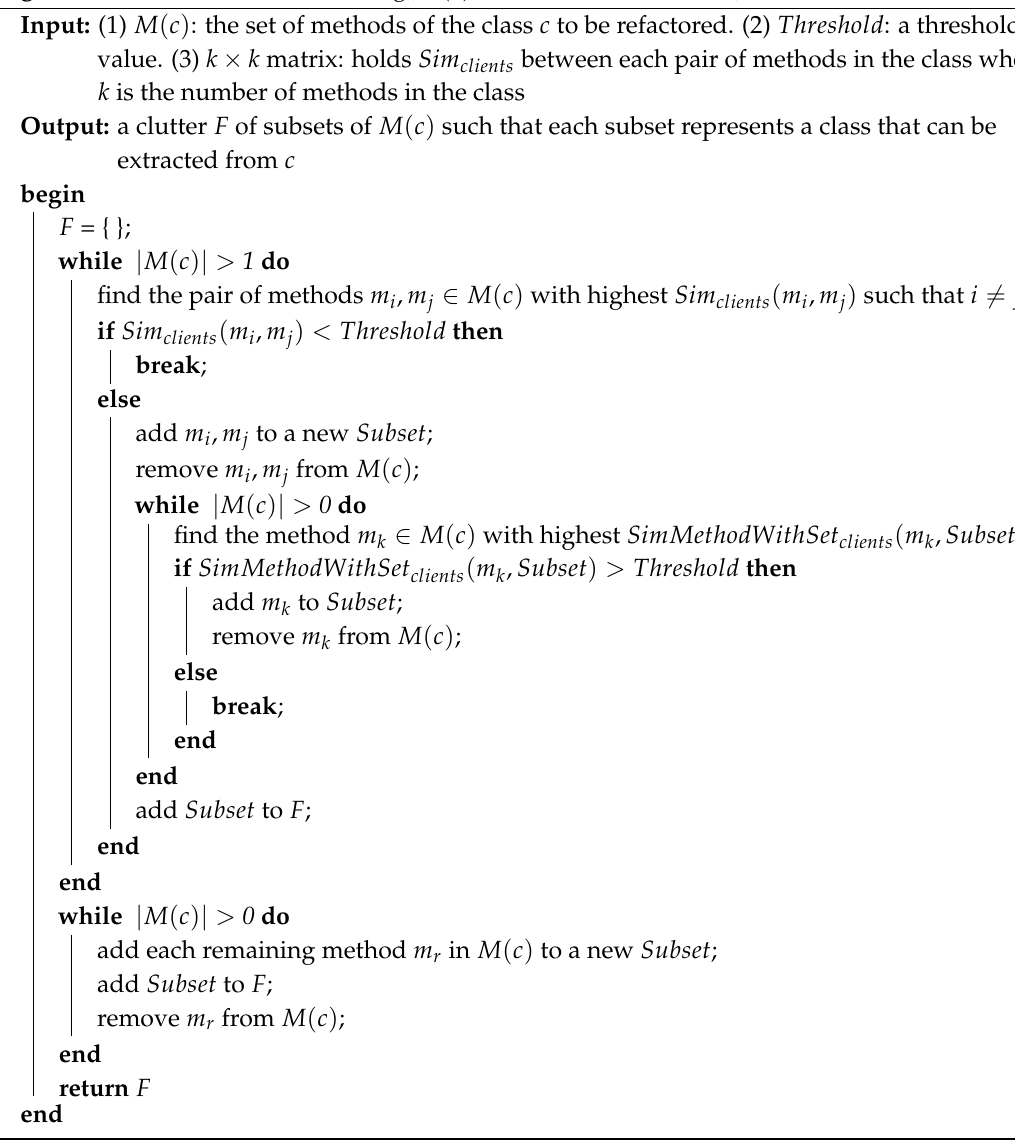
Algorithm 1: ExtractClassRefactoring( M ( c ) , Threshold , k × k